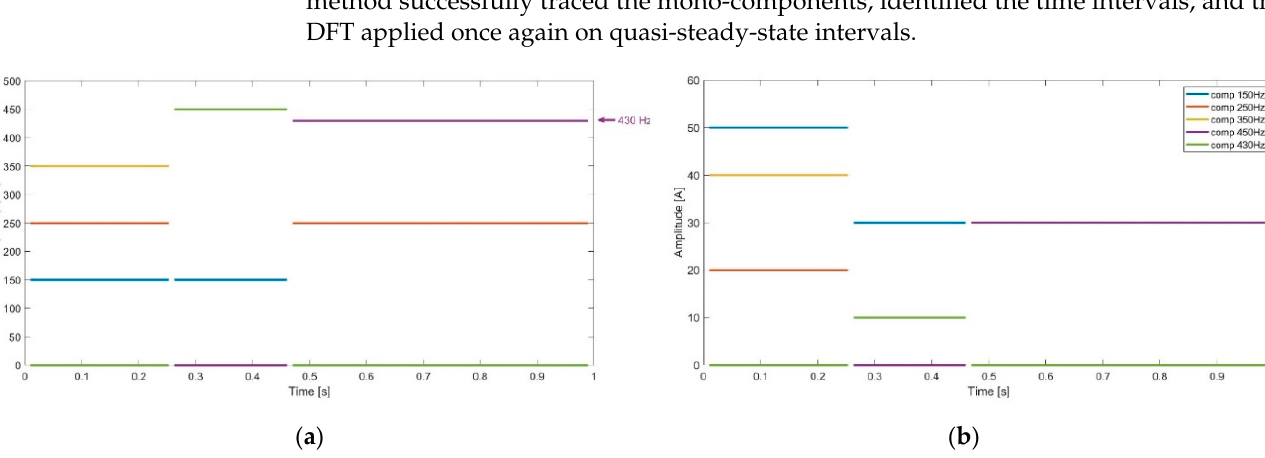
Figure 5. ( a ) Instantaneous frequencies and ( b ) amplitudes, of the mono-components extracted using the hybrid Hilbert- Huang method, of the synthetic signal described in Table 1.